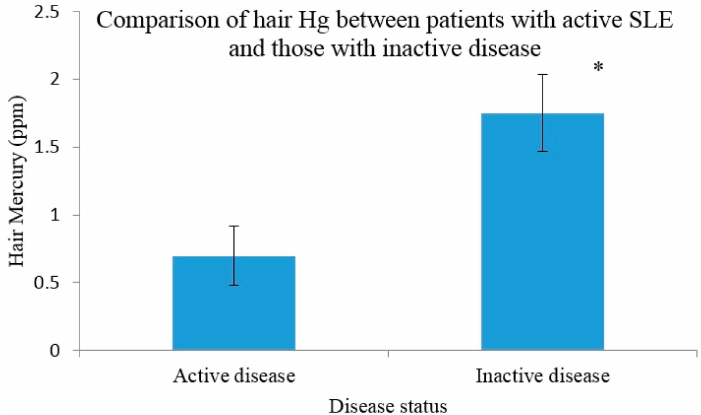
Figure 1. Hair mercury levels in systemic lupus erythematosus patients stratified by disease activity (SLAM) using 7+ as a cut off. Error bars indicate the SEM. * denotes significance p <